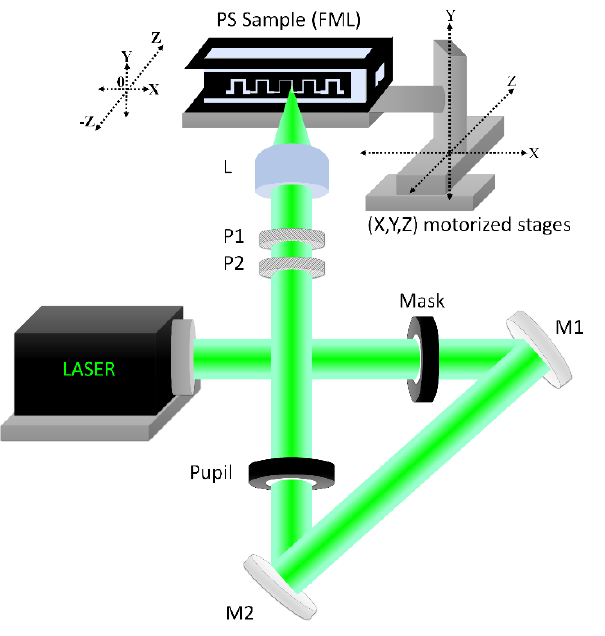
Figure 2. The optical system imprints the microchip features on a surface of a polystyrene cuvette. A green laser beam with an initial profile is rectified by a circular Mask. Two mirrors ( M1 , M2 ) redirect the beam toward the FML supporting stage. A circular pinhole filters the central part of the beam from their diffracted components as a Pupil. Two linear polarizers ( P1 , P2 ) set a convenient beam polarization. A plano-convex lens ( L ) focuses the beam at the surface of the FML. Three linear motorized stages (X, Y, Z, Thorlabs MTS50) are used.